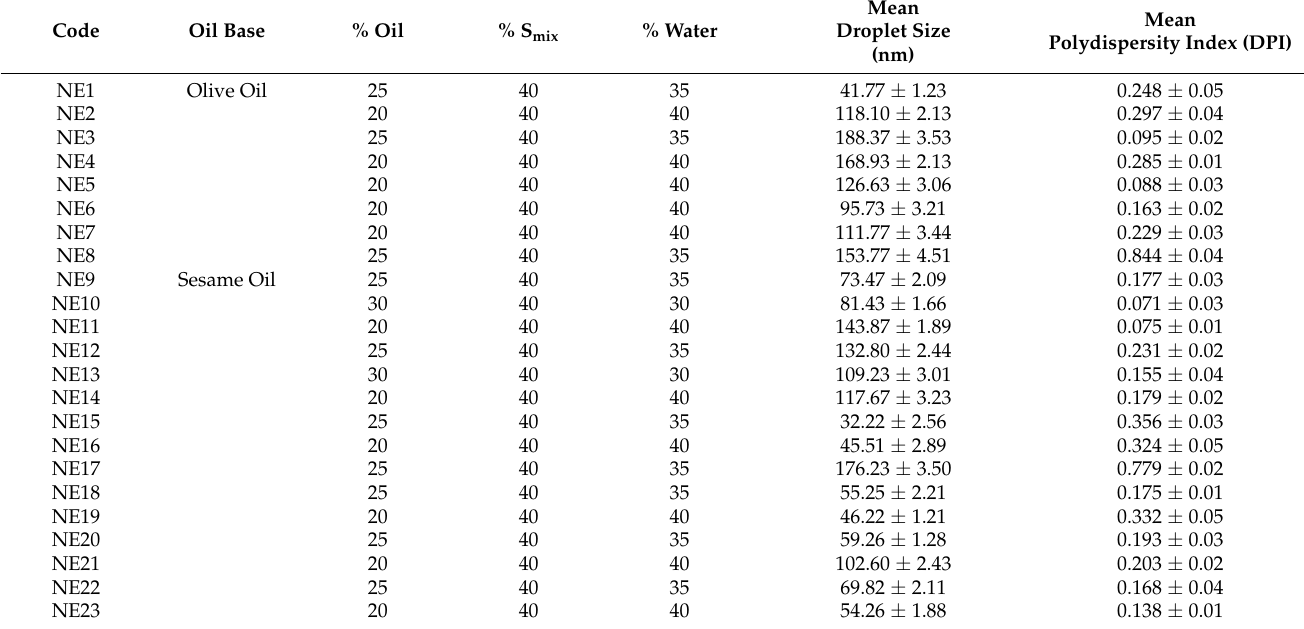
Table 2. Particle size analysis of stable 23 TAM-loaded NE out of the first 49-NE formulations prepared. The results are presented as mean ± S.D ( n =